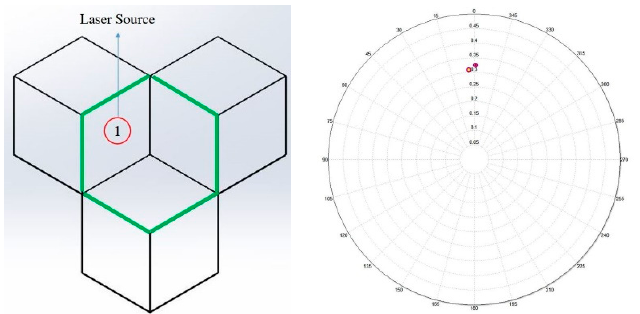
Figure 10. The CCCR #1 reflecting surface in the posterior region is hit by a simulated laser beam ( left ) and the resulting retro-reflected light intensity distributions ( right ).